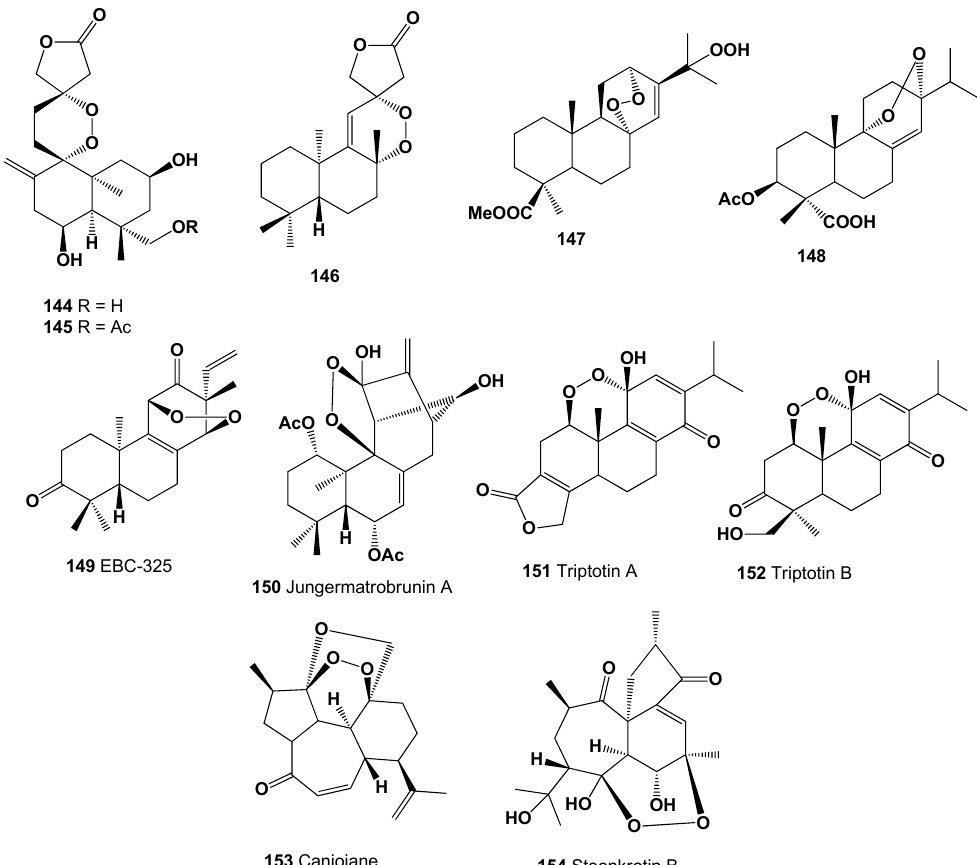
Figure 9. Bioactive polycyclic endoperoxides derived from plants.